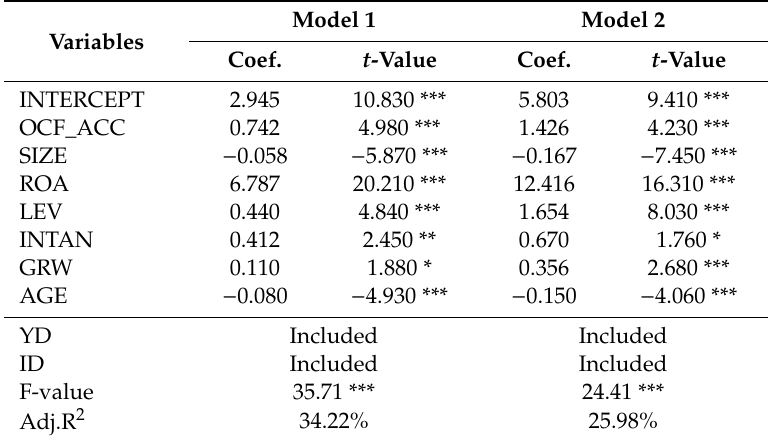
Table 6. Analysts’ cash flow forecasts accuracy and firm value.